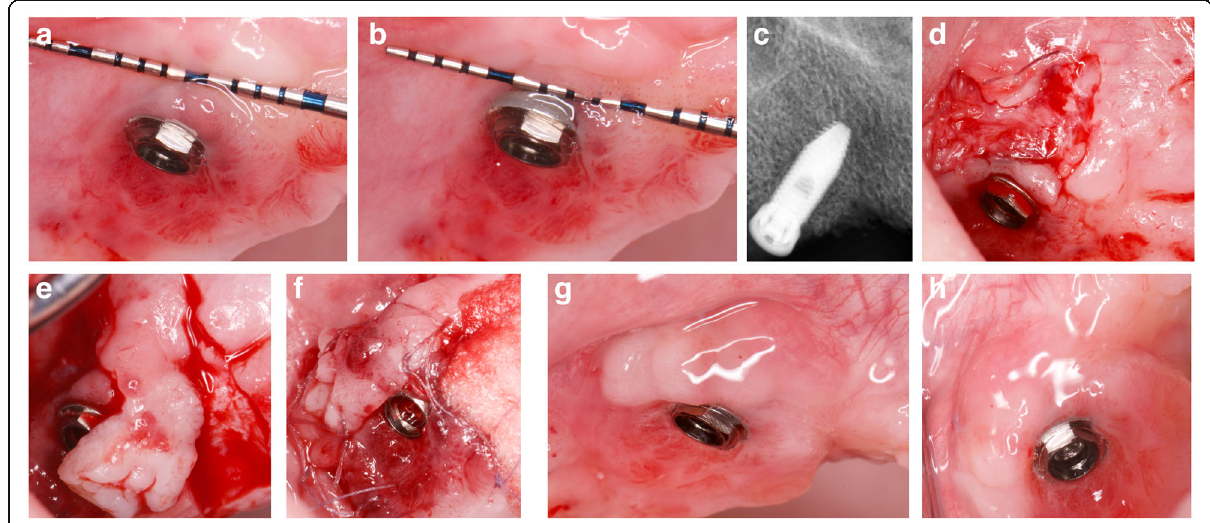
Fig. 4 Laterally rotated flap from the distopalatal area. a , b Pre-surgical situation. Peri-implant mucositis. Lack of keratinized tissue and marginal soft tissue mobility. c X-ray showing no peri-implantitis. d Firm attached bleeding recipient area. e Pediculated flap from the distopalatal adjacent area. f Pedicle sutured to the recipient bed. Collagen sponge device protecting the donor area. g , h Nine months follow-up showing a keratinized and increased peri-implant healthy soft tissue. Frontal and occlusal